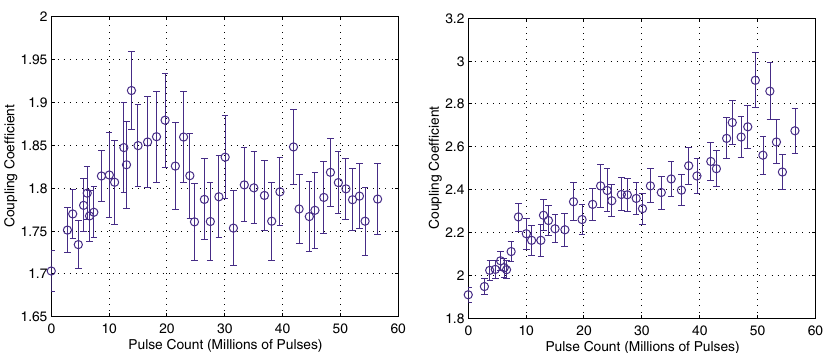
FIG. 15. (Color) Variation of (cid:25) for cavity 1 (left panel) and cavity 2 (right panel) as a function of pulse count at a 120 K temperature rise on the end cap surfaces. The errors shown are due to random errors only.